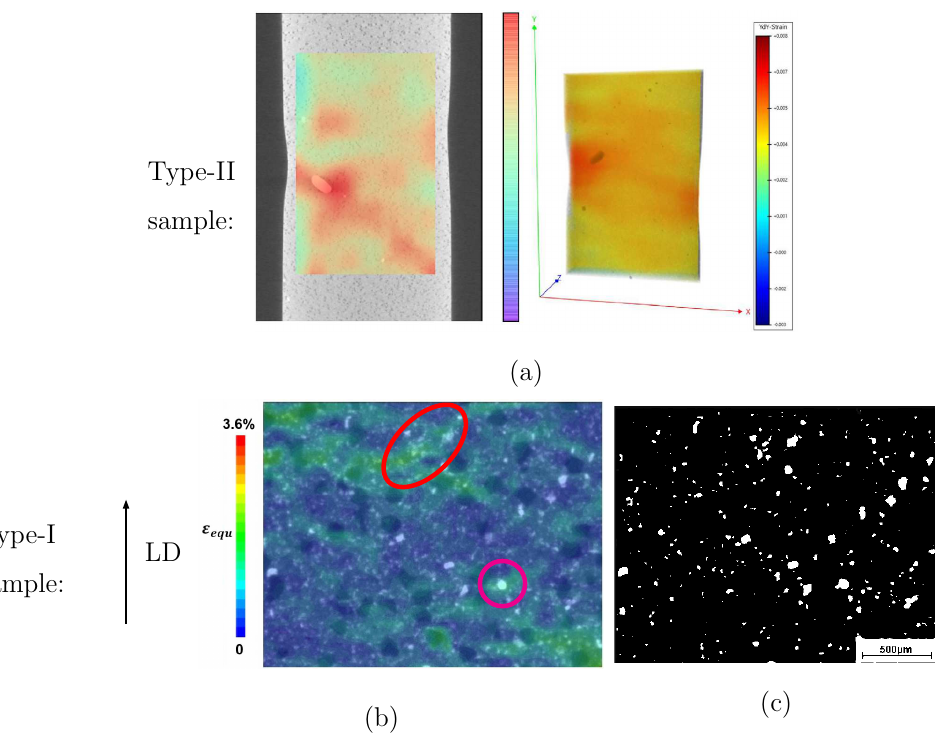
Fig. 9: Measured local strain distribution: (a) results of image correlations from RIF e.V. (left, 2D DIC) Figure 9. Measured local strain distribution: ( a ) results of image correlations from RIF e.V. (left, 2D and from VEDDAC [60] (right, 3D DIC), which is proved by Chemnitzer Werkstoffmechanik GmbH; (b) DIC) and from VEDDAC [60] (right, 3D DIC), which is proved by Chemnitzer the measured local equivalent plastic strain ε equ [49, 50] for the real microstructure shown in Fig. 3 (a), where the arrow shows the loading direction; (c) the segmented WC phase of (b).